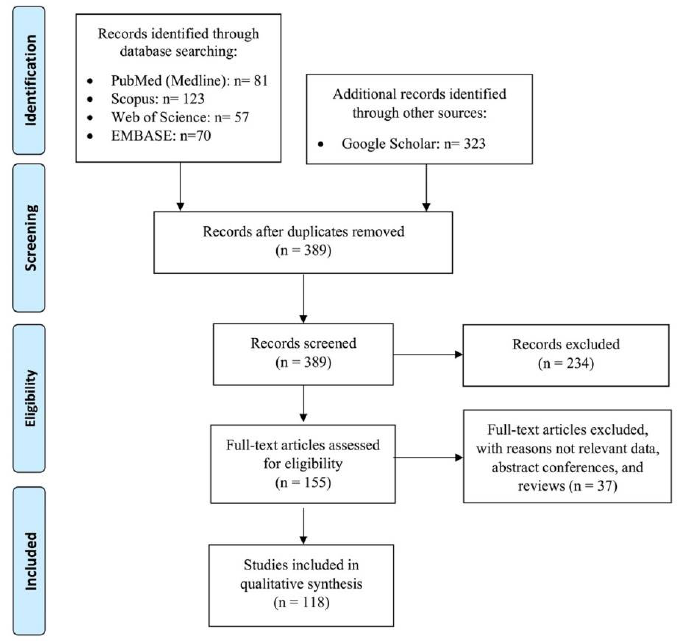
5 Figure 4. Magnetic Resonance Imaging of Case 2. Post-contrast magnitude inversion recovery (MAG-IR) ( A ) and phase-sensitive inversion recovery (PSIR) ( B ) images in short-axis views show subepicardial enhancement in the inferolateral wall at the base (arrowheads). Native T1 map shows corresponding abnormality (arrowheads in ( C )) with elevated values ( D ) in the inferolateral wall compared with the interventricular septum. T2 mapping also showed abnormality in this region (arrows in ( E )) with elevated values ( F ) when compared with the interventricular septum. Re- printed/adapted with permission from Ref. [15] 2021, Elsevier. 3. Results